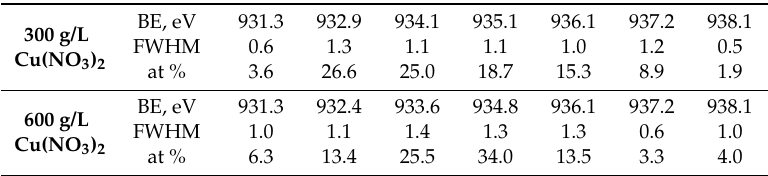
Table 5. Fitting results of Cu 2p 3/2 high resolution XPS spectra: BE—Binding Energy, FWHM—Full width at half maximum.